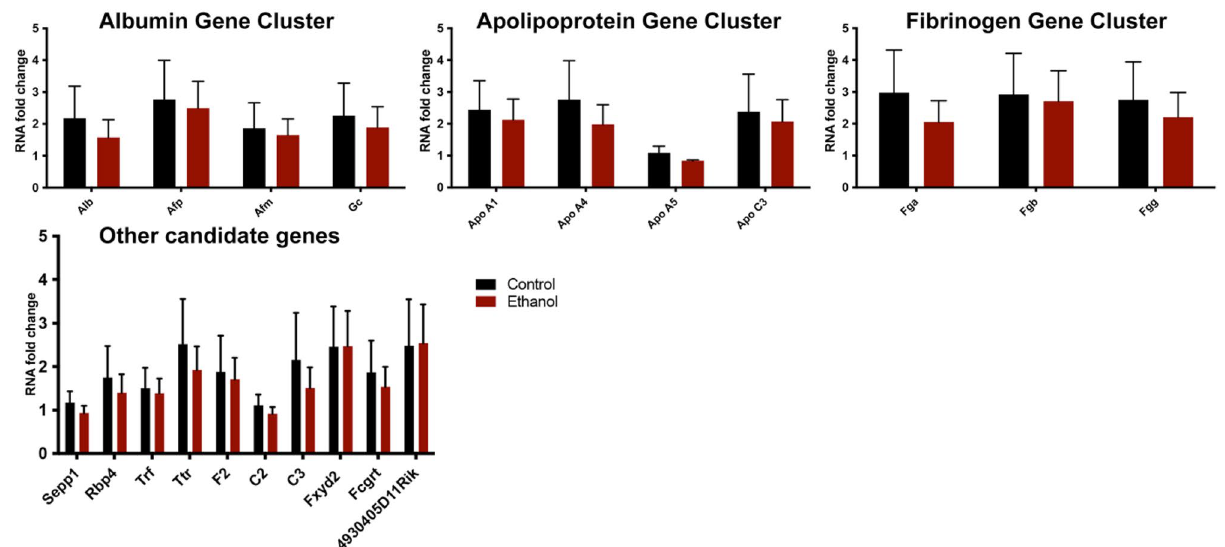
Figure 6. Placentae derived from the female offspring of EtOH-exposed sires do not exhibit altered gene expression of candidate genes identified in the male offspring. Using RT-qPCR and RNA samples isolated from female placentae derived from the offspring of EtOH-exposed sires, we assayed the expression of candidate genes within the albumin , apolipoprotein , and fibrinogen gene clusters, as well as other candidate genes identified in RNA-sequencing experiments. We normalized gene expression to the geometric mean of transcripts encoding Sdha , Mrpl1 , and Hprt (n = 8) and compared treatments using a one-way ANOVA. Error bars represent the standard error of the